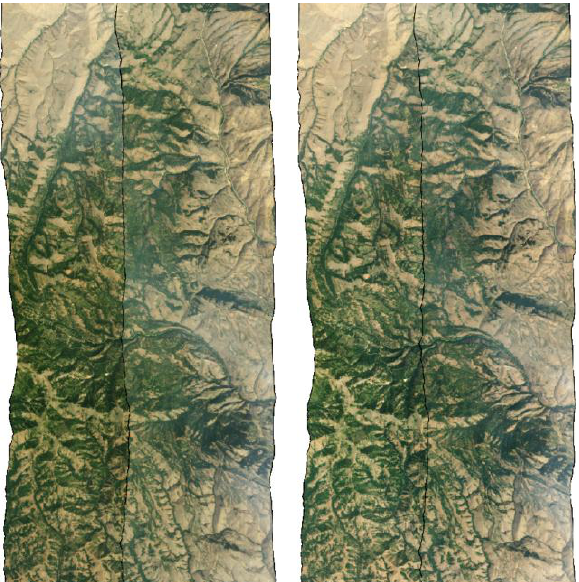
Figure 6. Comparison of radiometric normalization approaches for a section of an ADS ortho-image overlap of approx. 100,000 pixels along strip. Left: Result from the polynomial correction model of Gehrke (2010); right: result from the new radiometry fix approach with a spacing of 5,000 pixels.